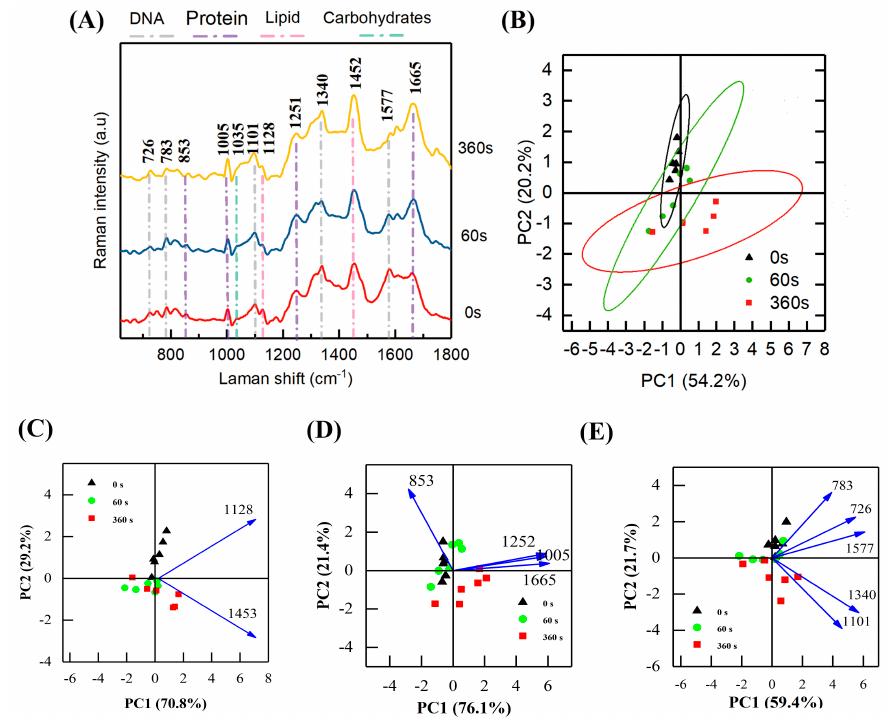
Figure 5. Raman spectra ( A ) and principal component analysis plot ( B for all bands, C for bands of lipids, D for bands of proteins, and E for bands of DNA) of A. acidoterrestris treated by cold plasma (input power: 1.32 kV; gas flow: 130 mL/min) at 0, 60, and 360 s, respectively.